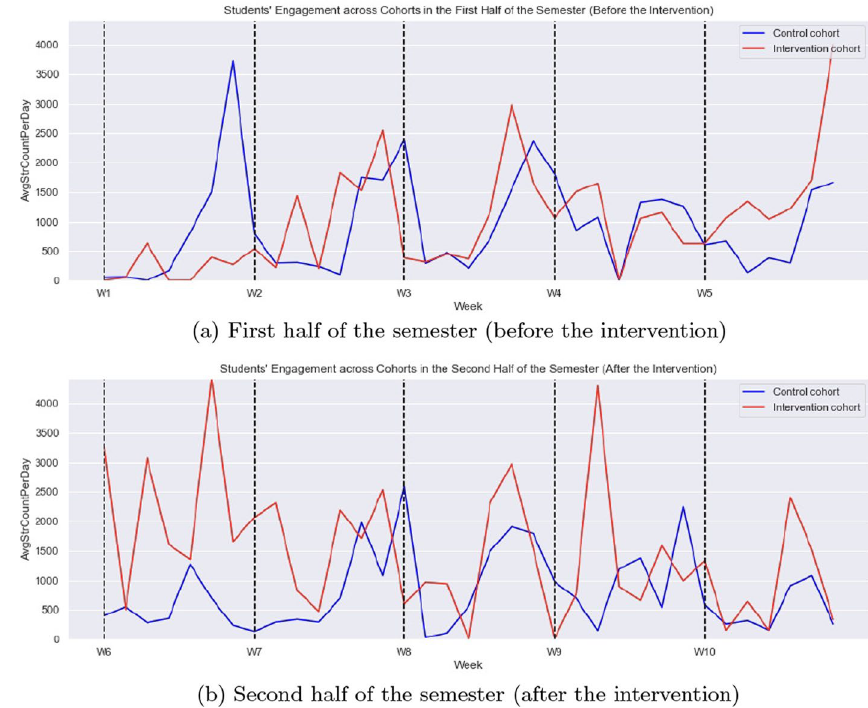
Fig. 2 AvgStrCountPerDay of both cohorts (the control group: blue line, the intervention group: red line) across semester. The vertical line denotes Monday of the week